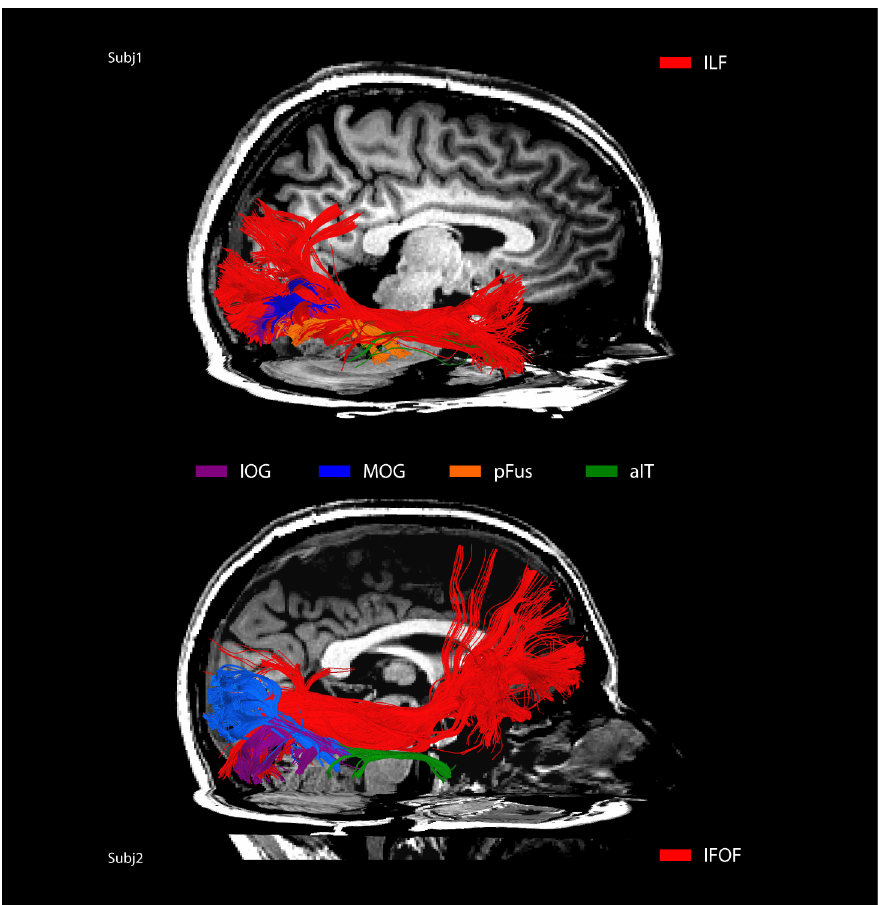
Figure 7. Spatial overlap of right ILF and IFOF with mFus connected tracks in two representative participants. The major ILF and IFOF tracts are colored red, and the mFus connected tracks are colored to correspond with their target ROIs. IFOF is show in the top participant and ILF in the bottom participant.